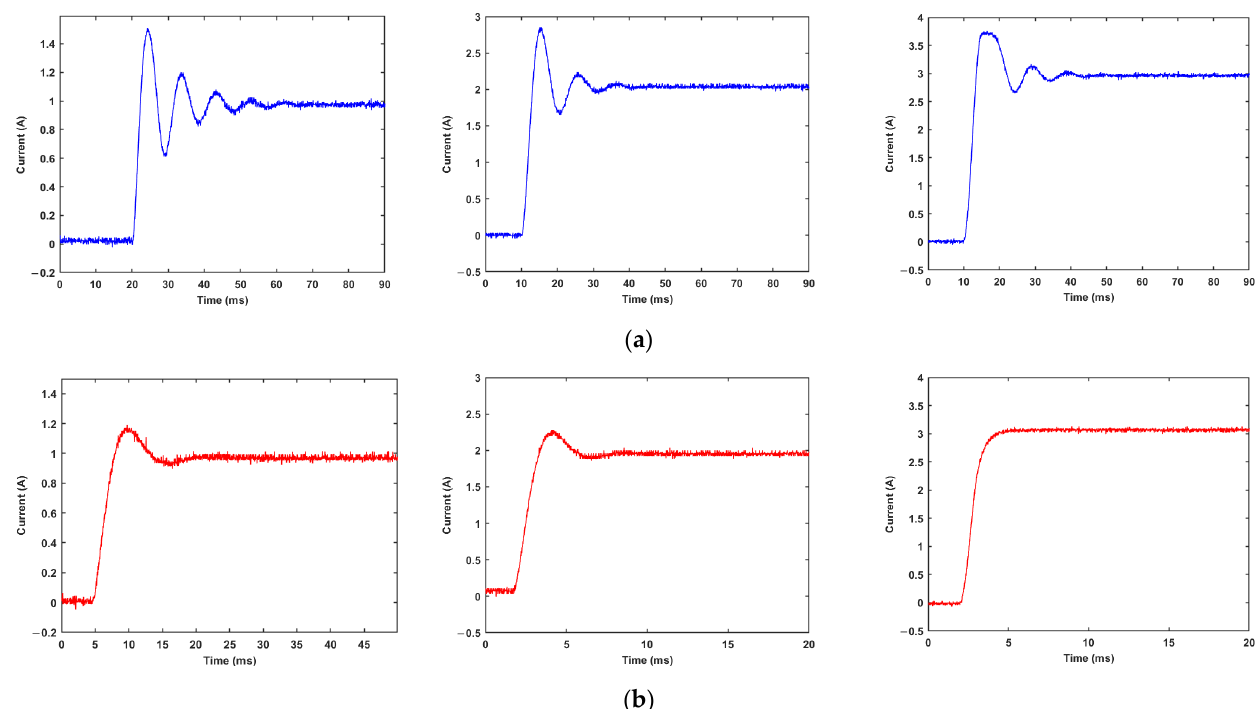
Figure 15. Response of current driver at 1 A, 2 A, 3 A step current after parameter changes: ( a ) PI controller; ( b ) fuzzy PI controller.